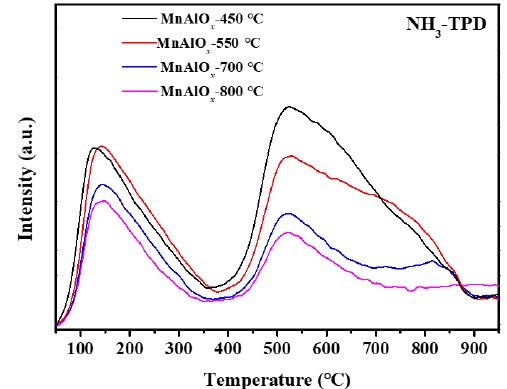
Figure 7. NH 3 -TPD profiles of the MnAlO x catalysts.